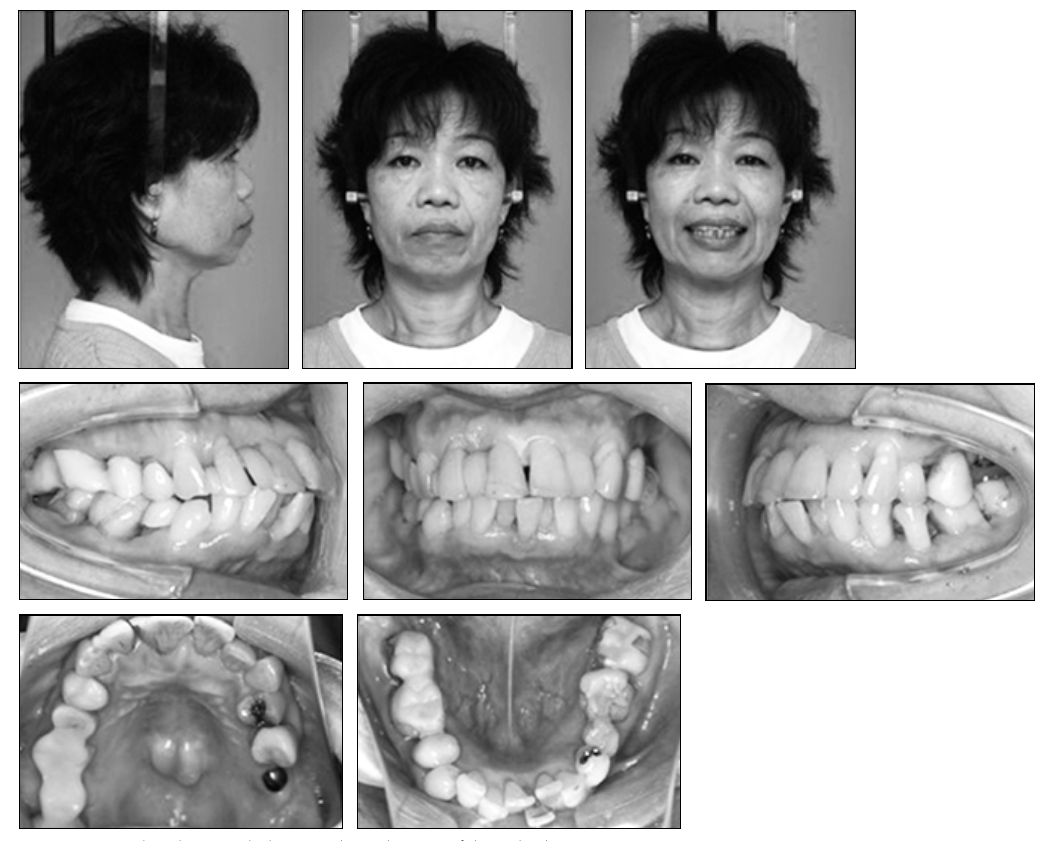
Figure 2. Facial and intraoral photographs at the start of the orthodontic